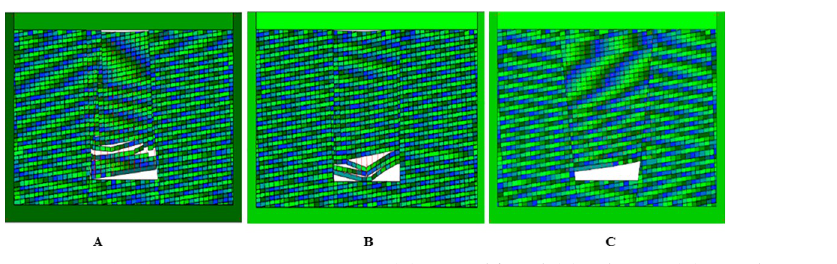
Fig 15. Simulated operation at 4000 time step. (A) Inverted funnel. (B) Columnar. (C) Funnel.